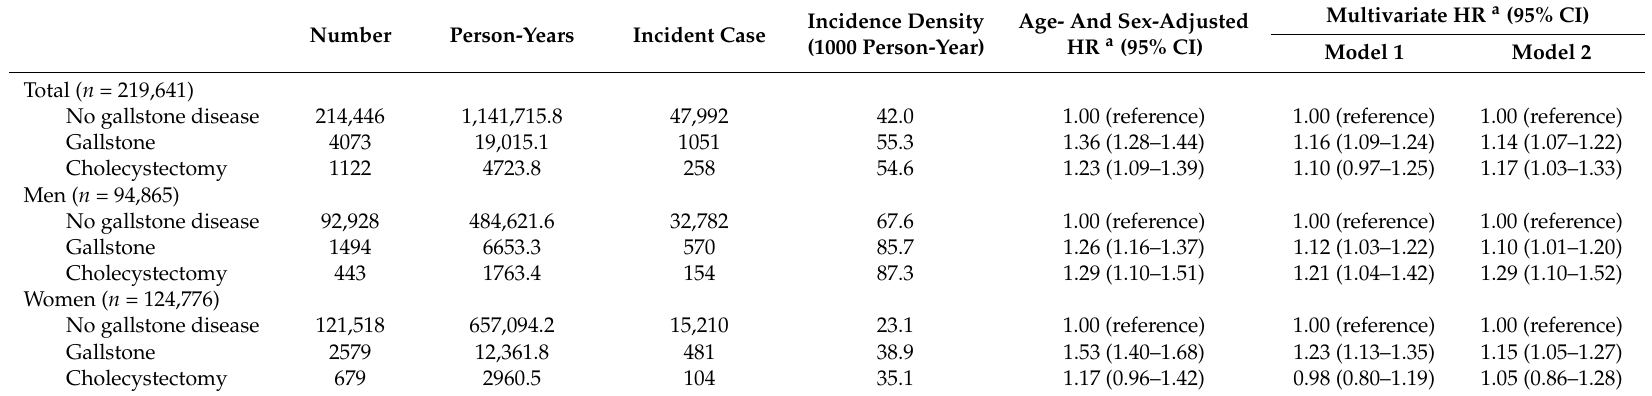
Table 4. The associations between gallstone, cholecystectomy and the development of nonalcoholic fatty liver disease (NAFLD) ( n =